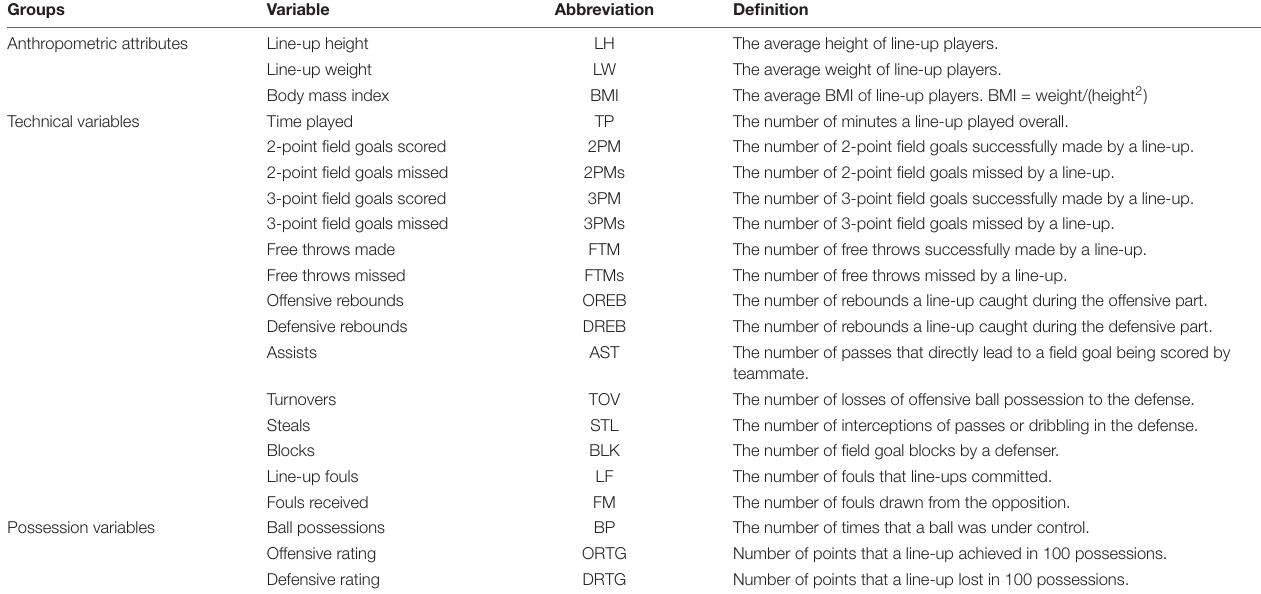
TABLE 1 | Operational definitions of 24 variables selected for the analysis.